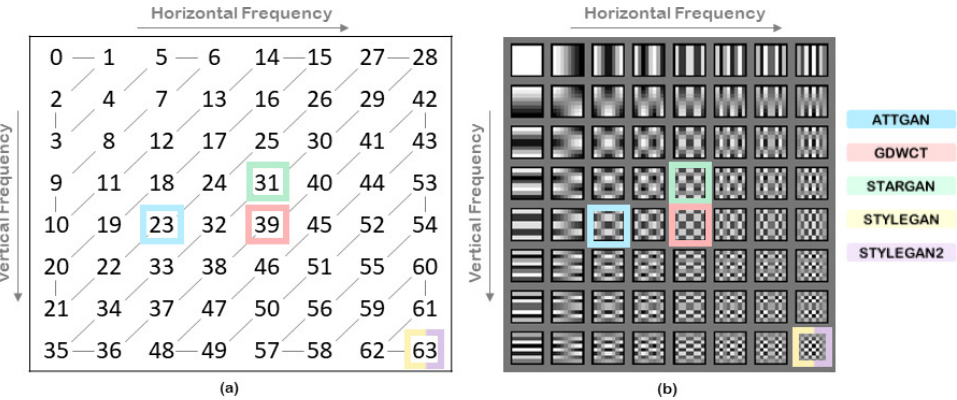
Figure 3. GSF that identify the generative architectures. ( a ) Zig-zag order after DCT transform. ( b ) DCT 8 × 8